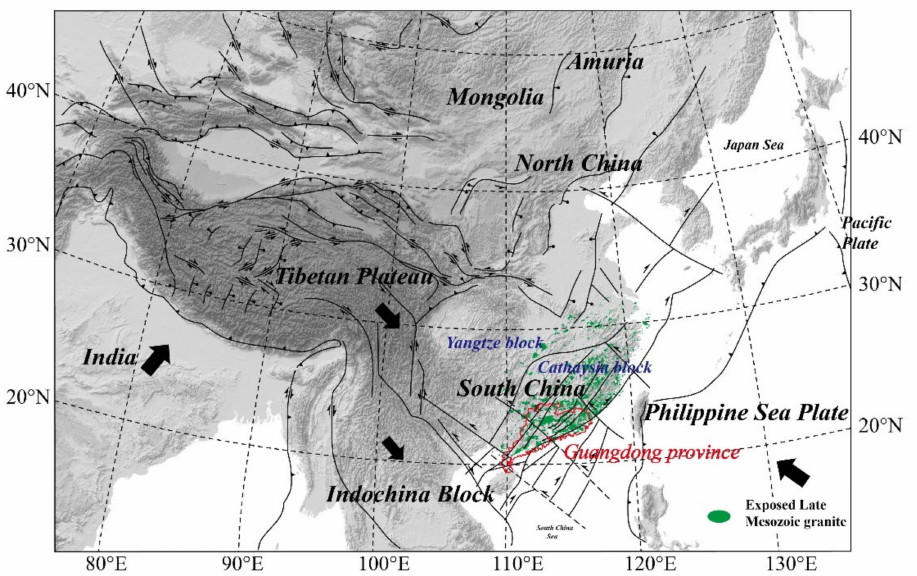
Figure 1. Tectonic map in East Asia and distribution of exposed Late Mesozoic granite in South China (modified from Kuang et al. [3]). The green area is the distribution of exposed Late Mesozoic granite, modified from Zhou et al. [4]. The red line is Guangdong